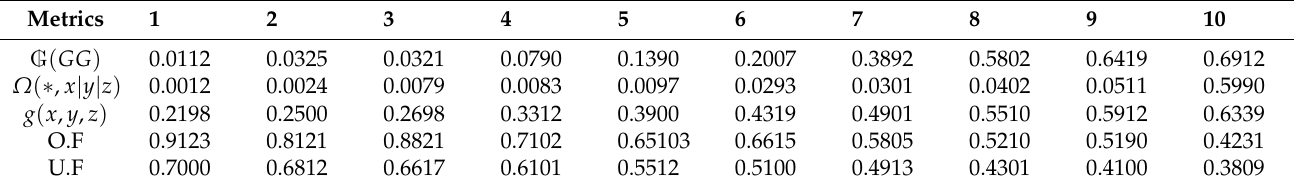
Table 5. Experimental analysis of the functions including GG